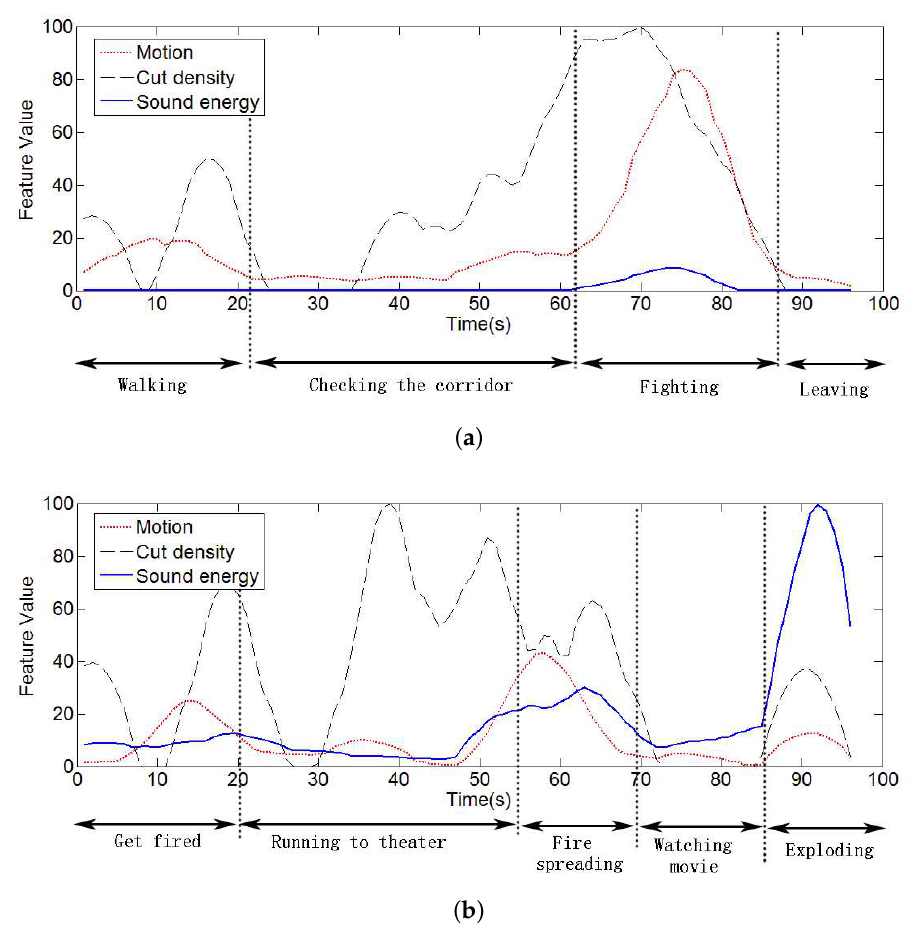
Figure 3. Low-level feature time curves of two short